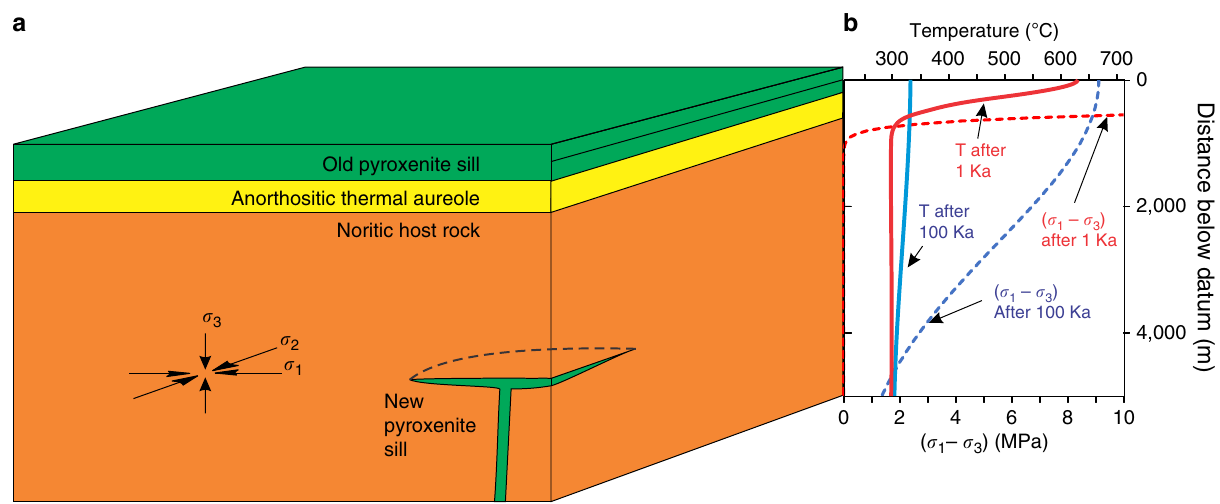
Figure 9 | State of stress and temperature in an infinite half-space occupied by a cooling sill 200m thick. ( a ) shows a schematic perspective view of a cooling sill flanked by anorthosite in a norite massif, with a new dike entering from the base and being deflected into a new sill parallel to the older sill. The orientations of the three orthogonal principal stresses are shown at lower left. ( b ) shows temperature and stress deviator 1,000 years and 100,000 years following emplacement of the first sill. The first sill and its partially melted anorthosite aureole are both completely solid after o 1,000 years. Even though temperature has largely relaxed to far-field values after 100,000 years, a substantial and upward-increasing stress deviator will tend to encourage subsequent intrusive dikes to deflect into sills in the s 1 – s 2 plane (illustrated schematically in a ). The depth of deflection will depend on the relative buoyancy of the new magma and on the magnitude of the stress deviator. Once initiated, new sills will be forced to propagate parallel to existing sills perpendicular to the minimum compressive stress direction of the deviatoric stress tensor.